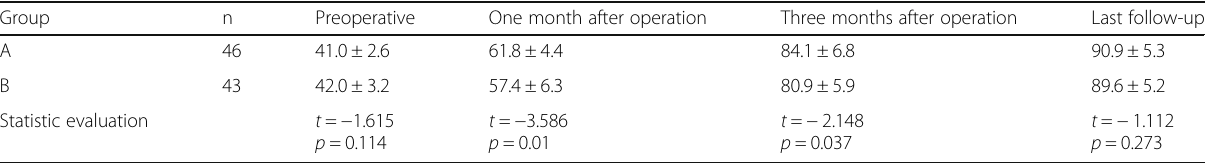
Table 2 Comparison of Harris scores at pre- and post-operation between 2 groups ð x (cid:3) s Þ Group n Preoperative